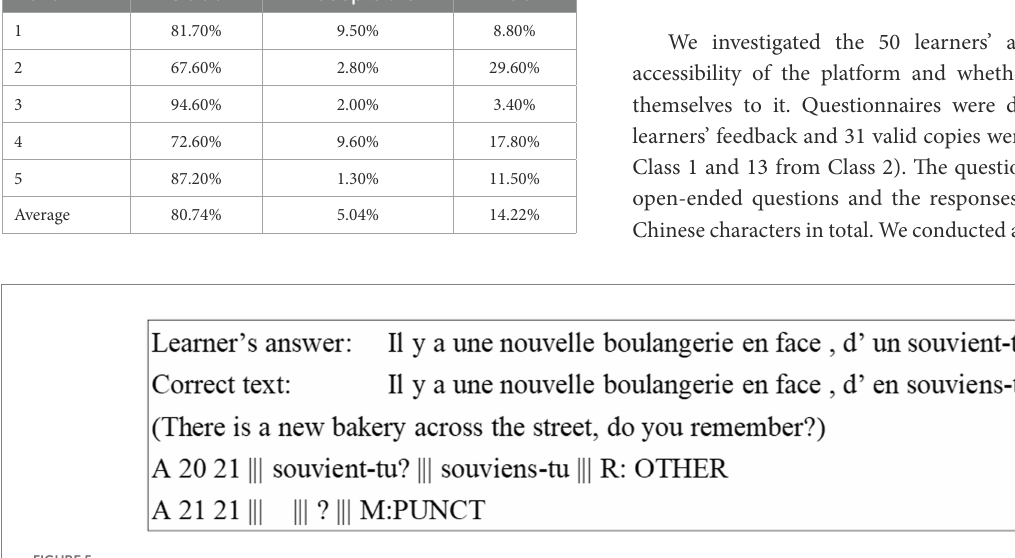
TABLE 4 Result of manual evaluation of predicted error types on 147 samples. Rater